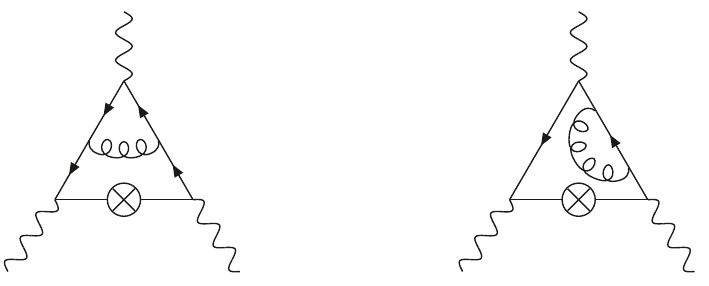
Figure 2 . Two examples of the two-loop perturbative topologies. The external static photon has been indicated by a crossed